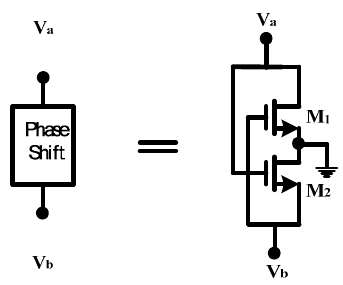
Figure 5. Proposed phase shift circuit.